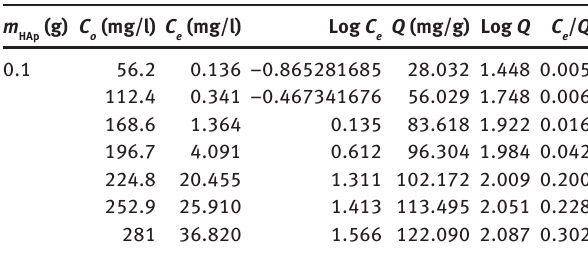
/ Q for the two e